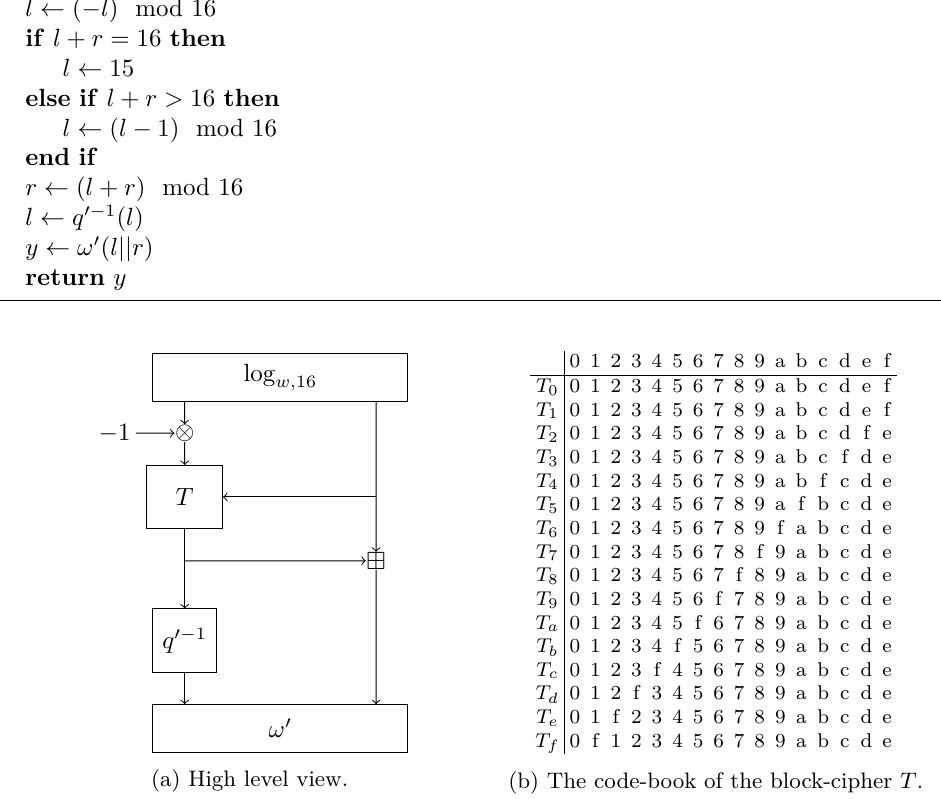
(b) The code-book of the block-cipher 𝑇 . Figure 8: Another decomposition of 𝜋